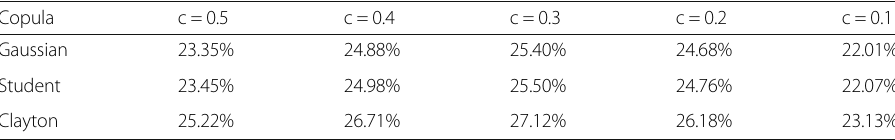
Table 6 Value-at-Risk at 99% for a portfolio of two assets